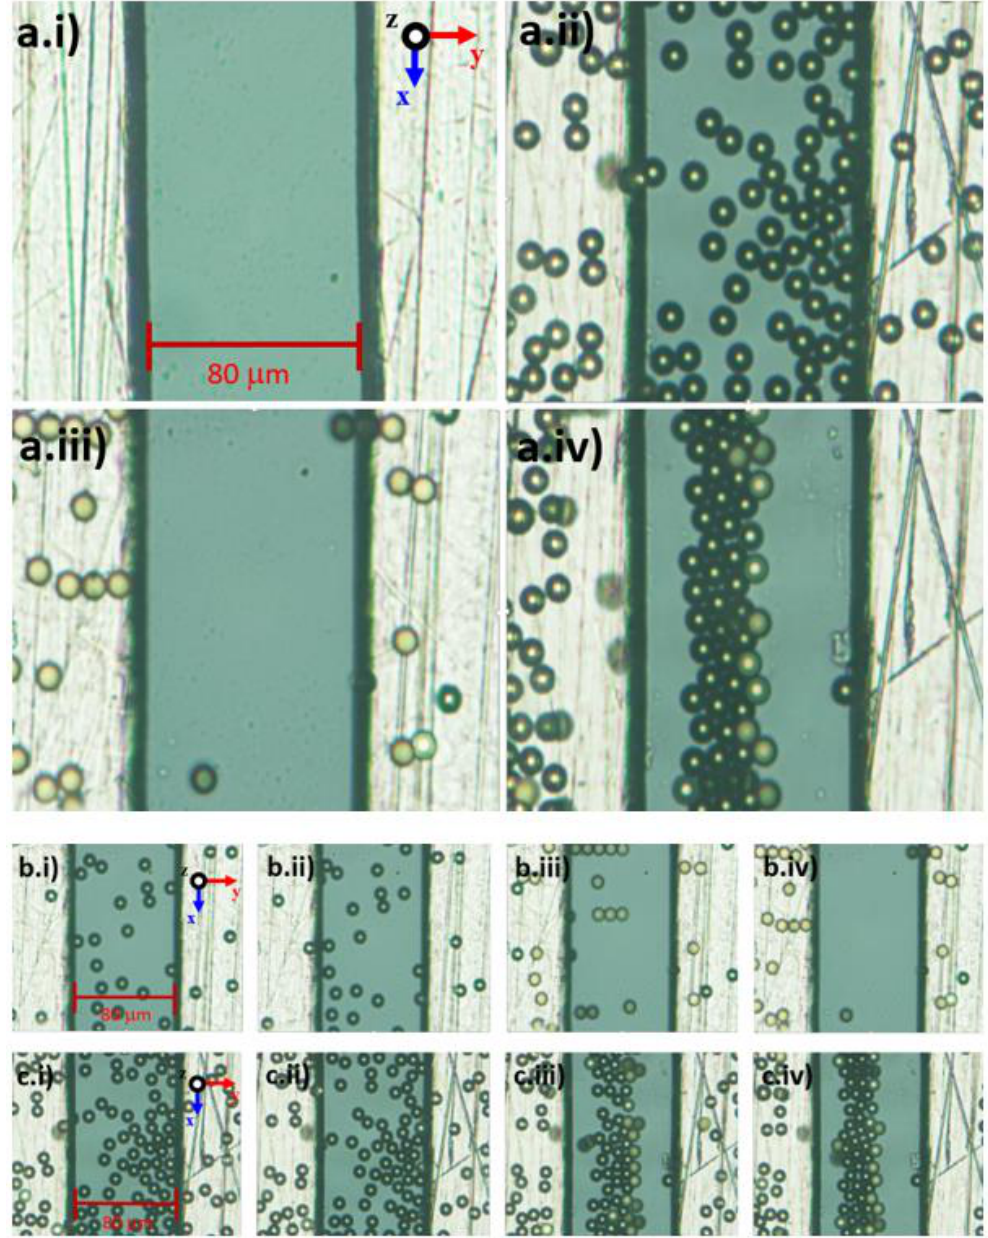
Figure 10. ( a ) The movement and direction of Ps in different conditions: (a.i) Di ionised water only, (a.ii) Di ionised water and Ps, (a.iii) P DEP and (a.iv) N DEP. ( b ) At the input frequency 10 KHz, 10 µ m Ps laterally attracted in the y-axis, P DEP : (b.i) 2 s, (b.ii) 5 s, (b.iii) 8 s and (b.iv) 10 s. ( c ) At the input frequency 2 MHz, 10 µ m Ps vertically repelled in the z-axis, N DEP : (c.i) 2 s, (c.ii) 5 s, (c.iii) 8 s and (c.iv) 10 s.